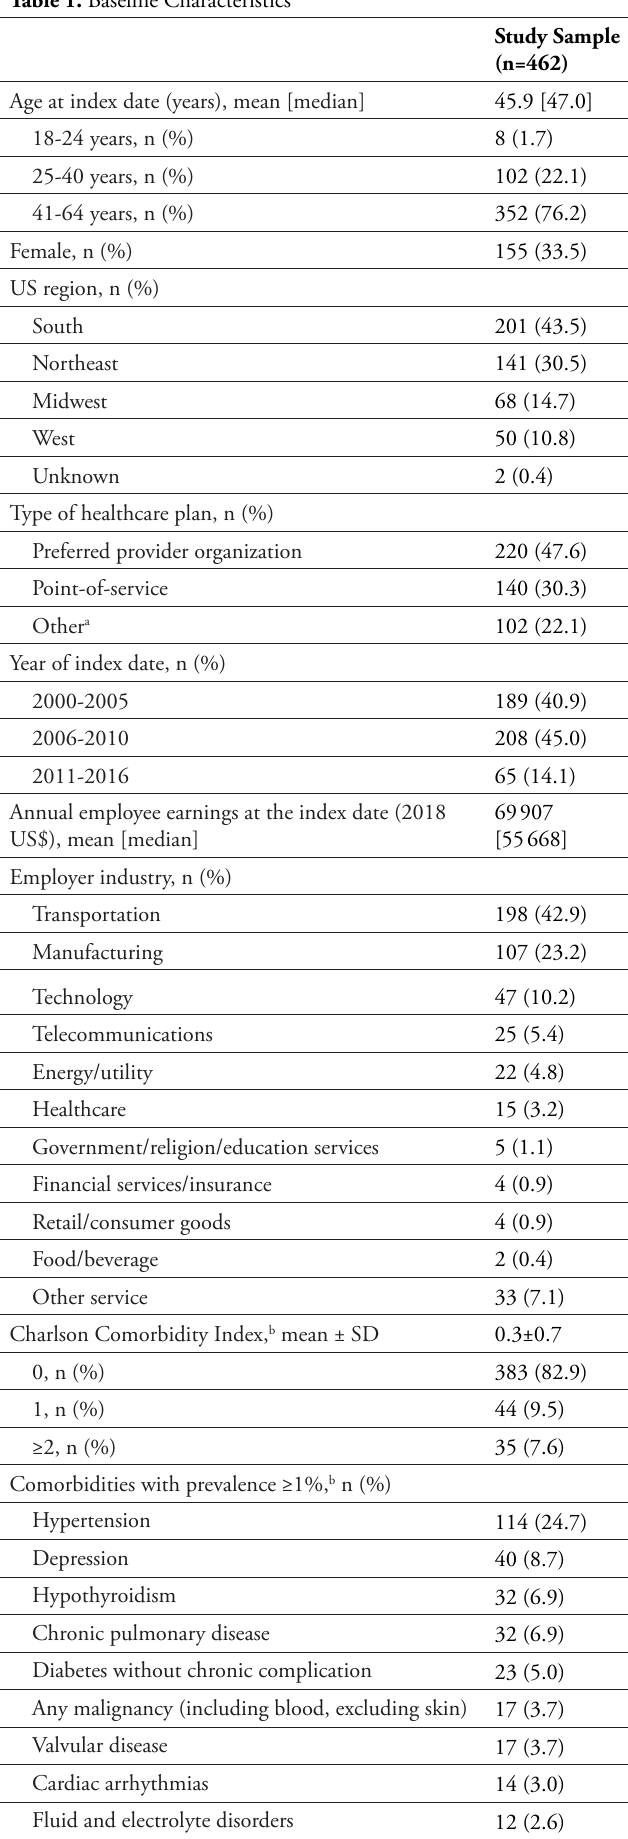
Table 1. Baseline Characteristics